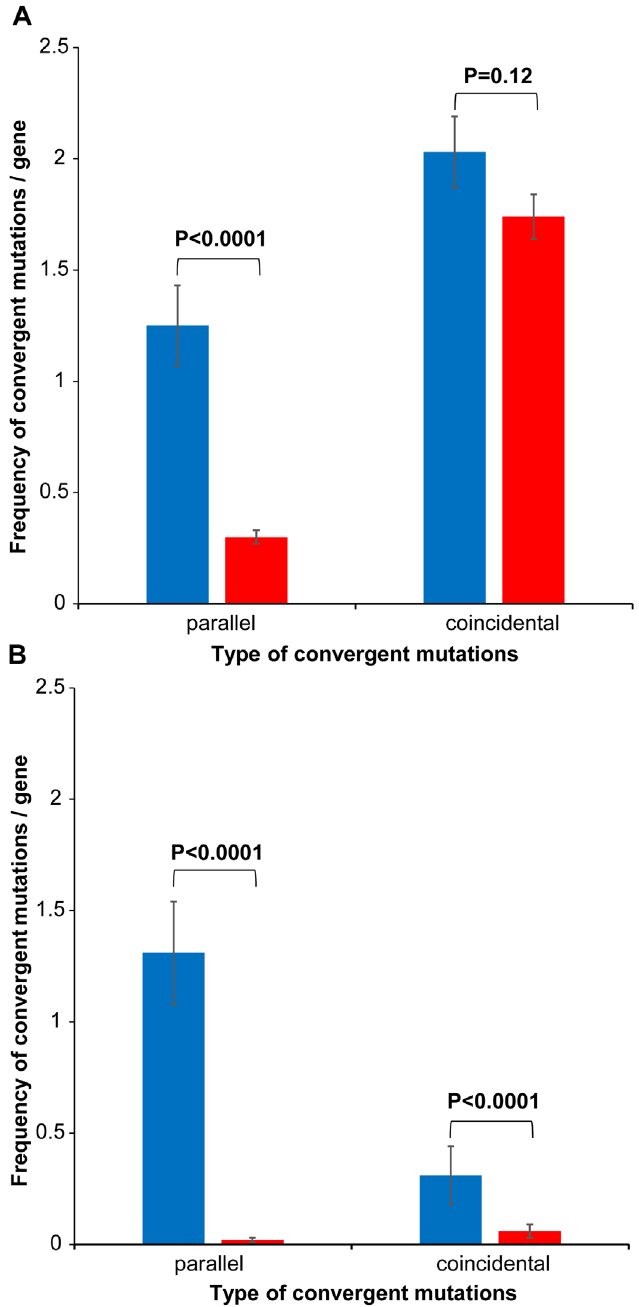
Fig 3. Frequency of parallel and coincidental convergent mutations in real (blue) and simulated (red) datasets. (A) 91 genes sharing convergent mutations between two sub-species (i.e., between Ver097 and one or more of the remaining 12 strains), and (B) 67 genes sharing convergent mutations within subspecies I (i.e., 12 strains excluding Ver097). Z-test P values are shown for each comparison between mean frequencies for real and simulated